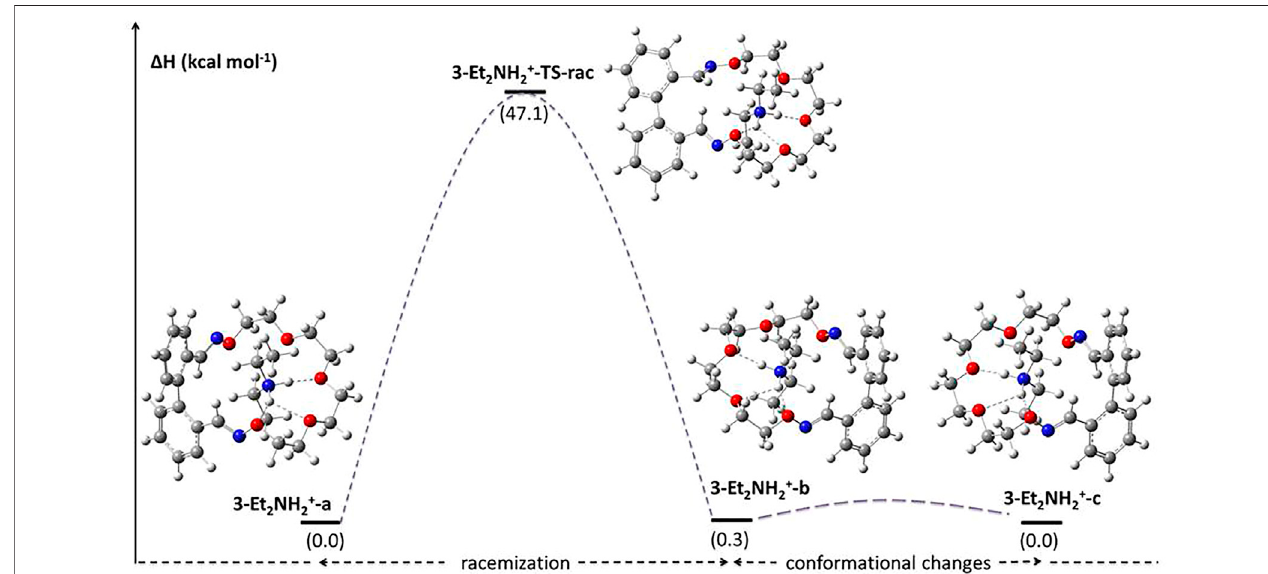
FIGURE 8 | DFT calculated relative enthalpies and barrier values (353 K, 1 atm) for the racemization mechanism of 3-Et 2 NH 2+ .